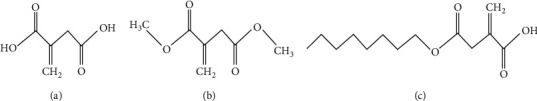
Itaconate and its derivatives. The structural formula for itaconate (a), DI (b), and 4-octyl itaconate (c).